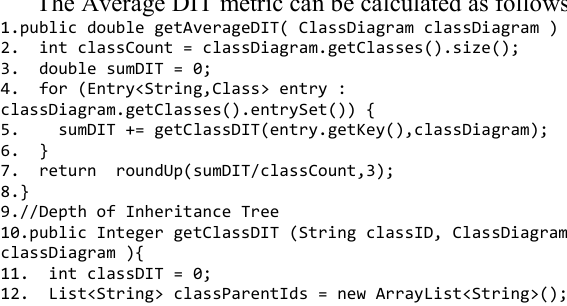
Fig. 3. UML class diagram of the UML Map classes providing UML class diagram storage, analysis and transformation